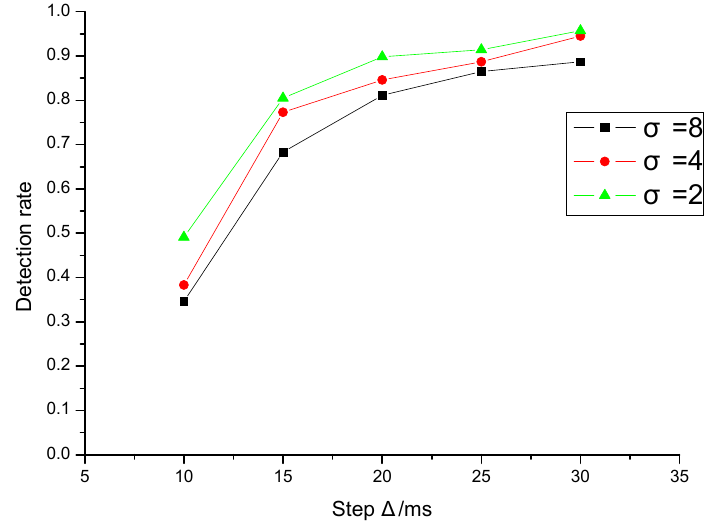
Figure 9. Effect of standard deviation of network jitter on detection